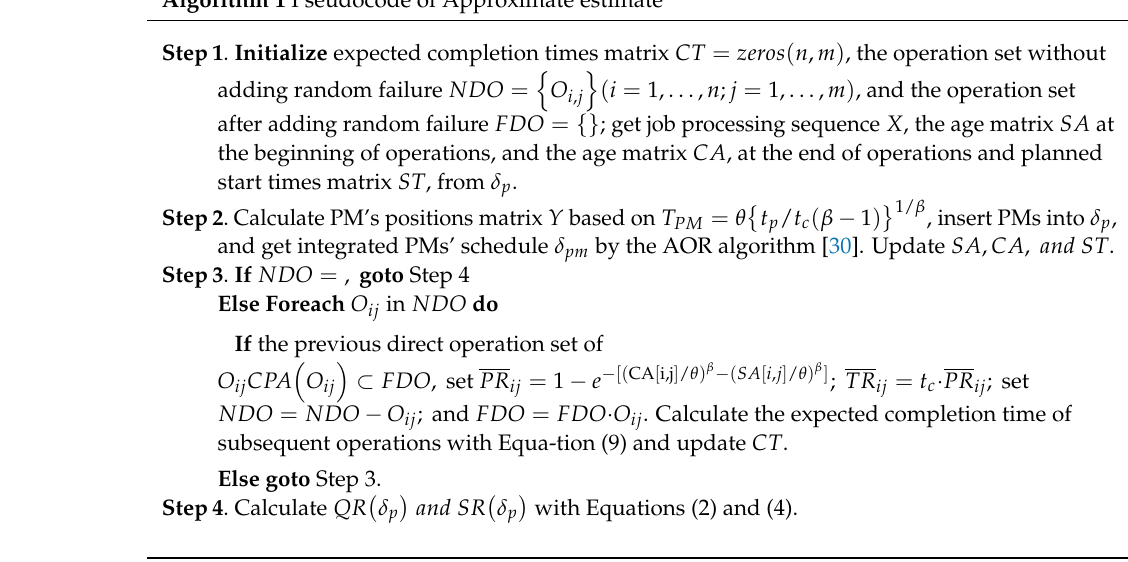
Algorithm 1 Pseudocode of Approximate